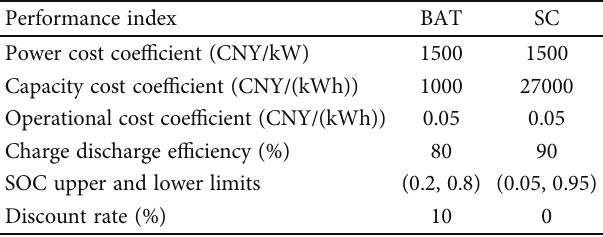
Table 3: Related parameters of the energy storage